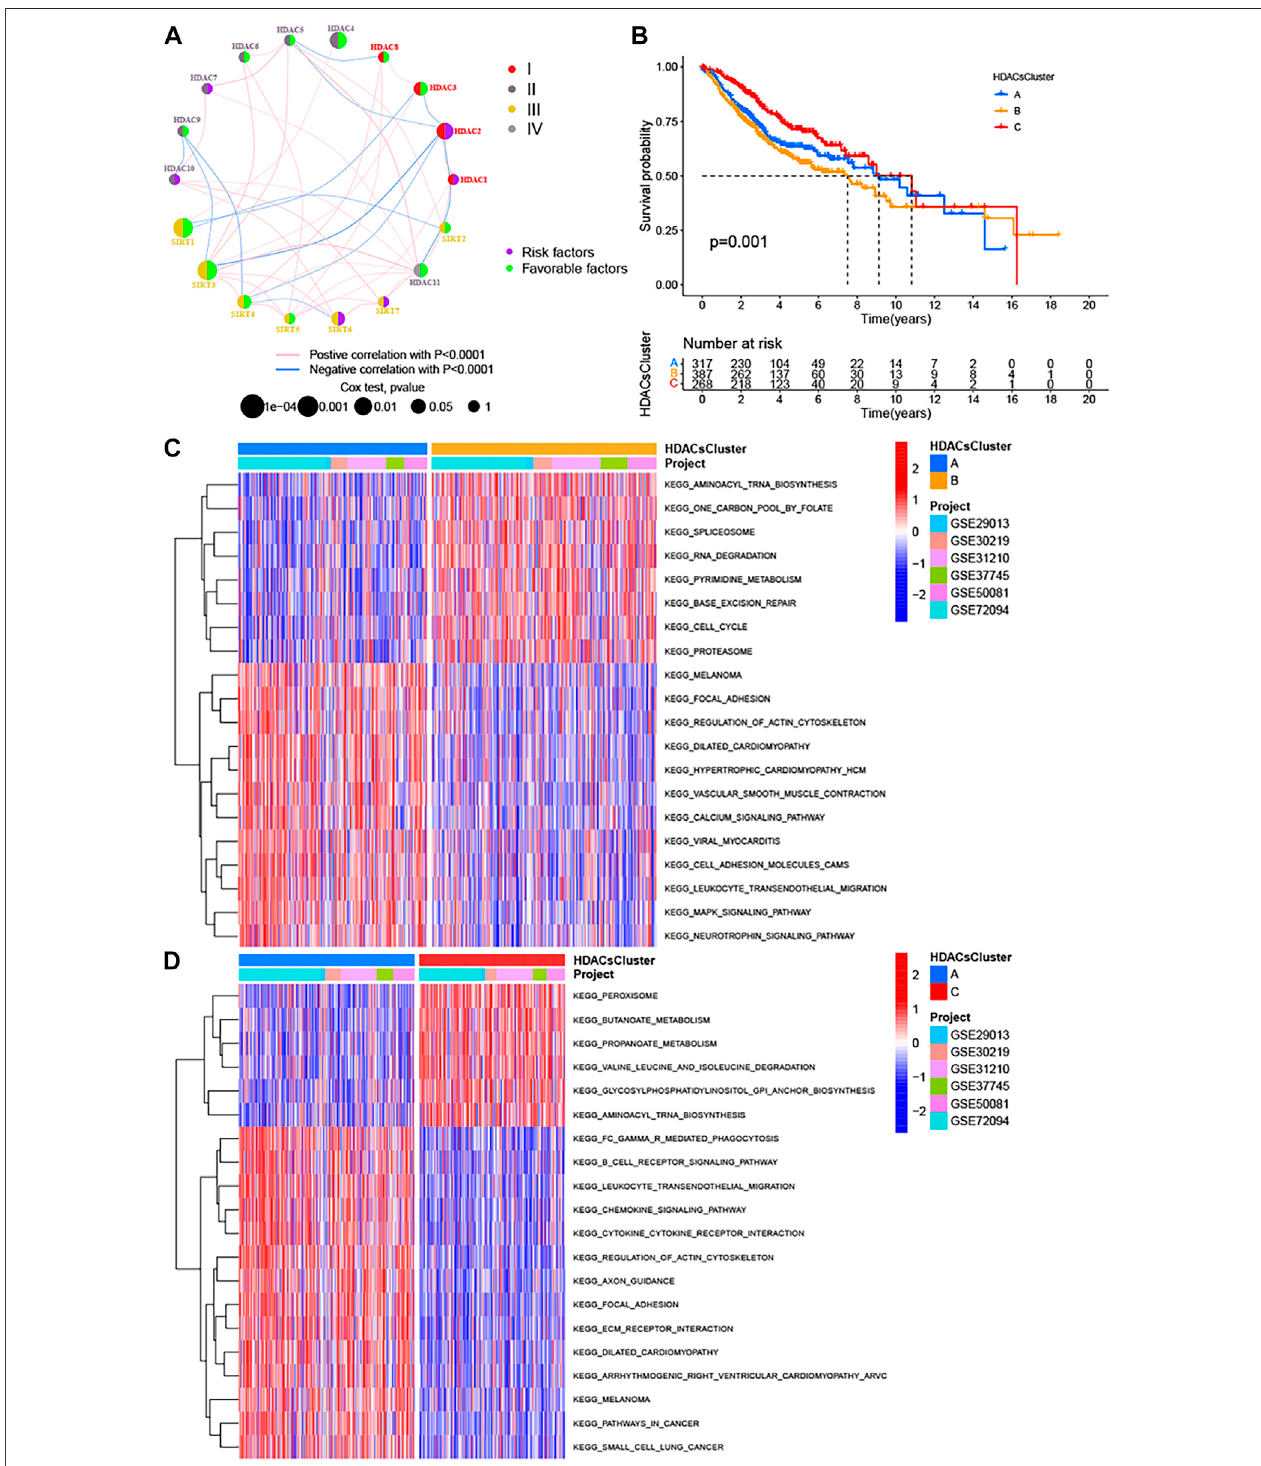
FIGURE 2 | Three distinct LUAD subtypes and biological characteristics of each subtype. (A) Interaction between 18 HDAC family genes in LUAD. The circle size representedtheeffectofeachregulatorontheprognosis,andtherangeofvaluescalculatedbythelog-ranktestwas p < 0.0001, p < 0.001, p < 0.01, p < 0.05,and p < 1, respectively. Left half of the circle: purple represents prognostic risk factors, and green represents prognostic favorable factors. Right half of the circle: the types of 18 HDAC family genes. The lines linking regulators showed their interactions, and thickness showed the correlation strength between regulators. Negative correlationwasmarked withblueand positivecorrelation withpink. (B) Kaplan − Meiersurvivalanalyses forthethree distinct LUADsubtypes based on972patientsfrom